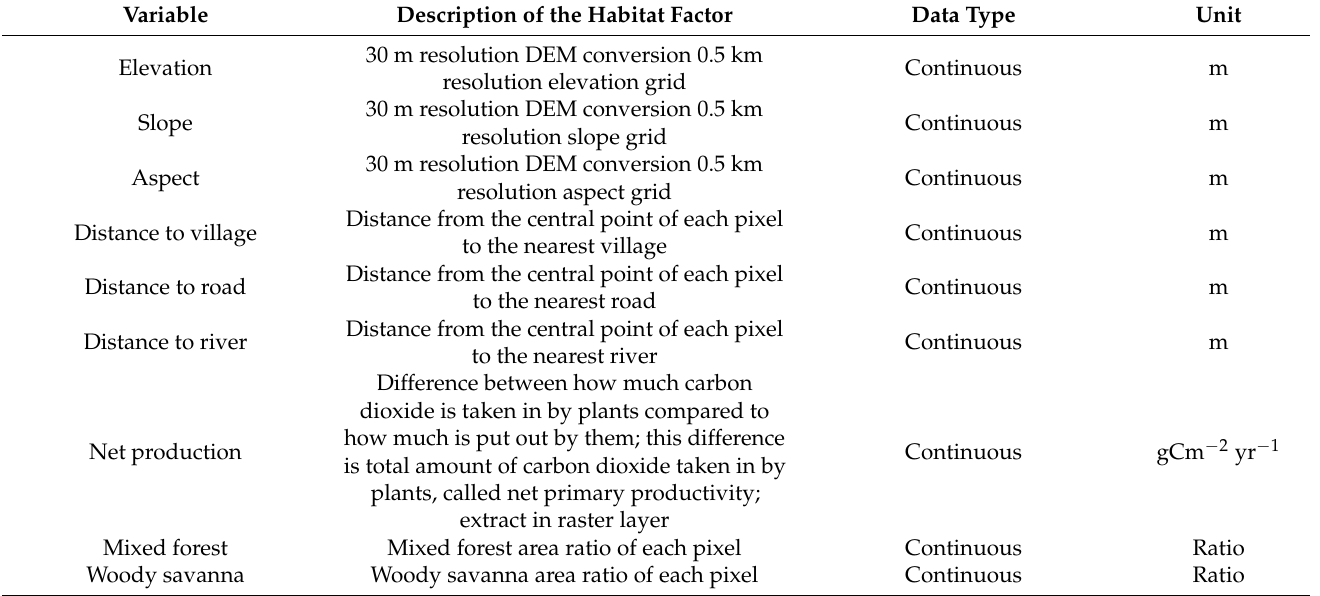
Table 1. Environmental variables used to analyze the density distribution of North China leopards and the distribution of their prey. Note: Data were processed in ArcGIS 10.6 in grid format (0.5 × 0.5 km pixel) on the basis of re-sampled or interpolated measurements. Data were extracted from the National Geomatics Center of China (http://www.ngcc.cn/ngcc/ (accessed on 30 June